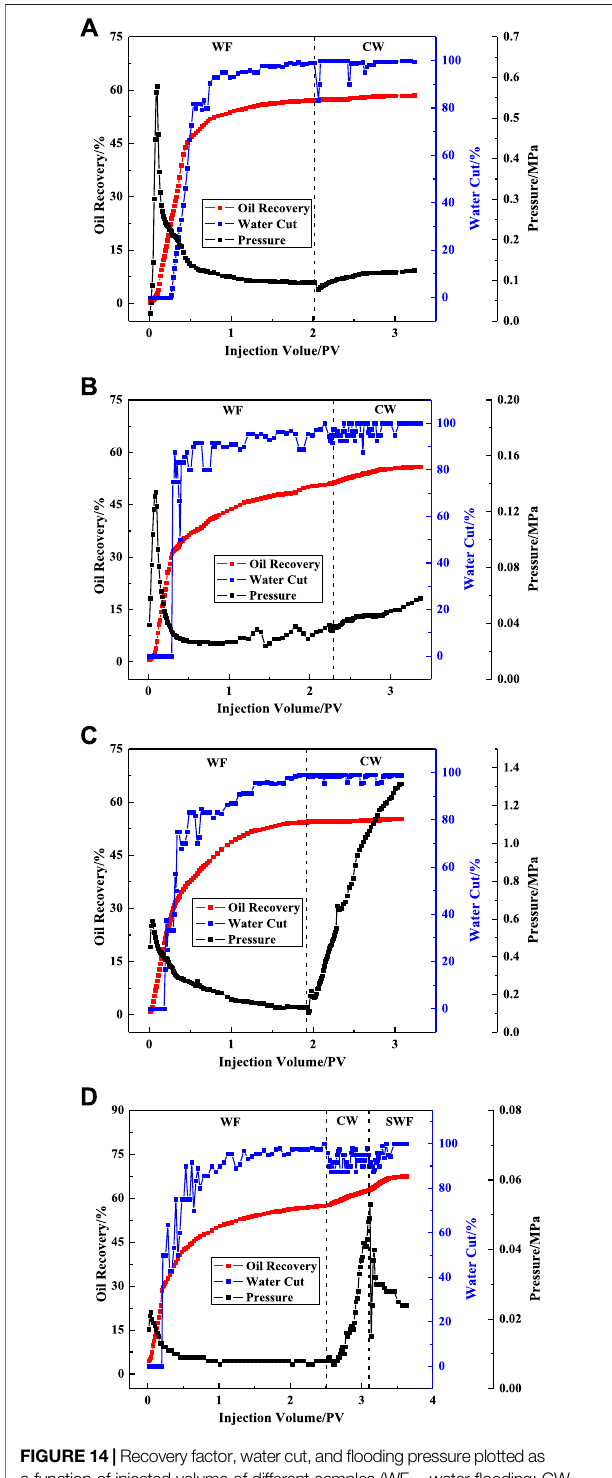
FIGURE 14 | Recoveryfactor,watercut,and fl oodingpressureplottedas a function of injected volume of different samples (WF (cid:2) water fl ooding; CW (cid:2) chemical fl ooding; SWF (cid:2) subsequent water fl